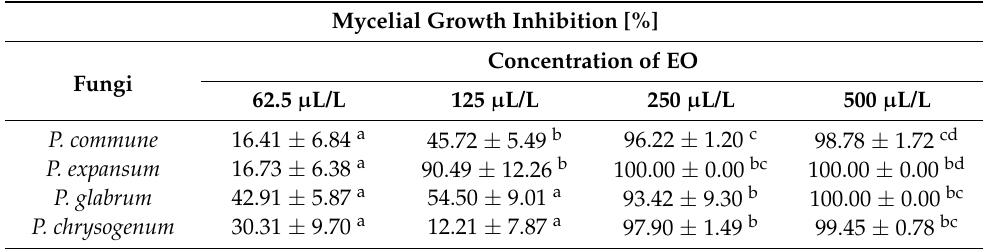
Table 3. In situ analysis of the antifungal activity of the vapor phase of CEO in bread.